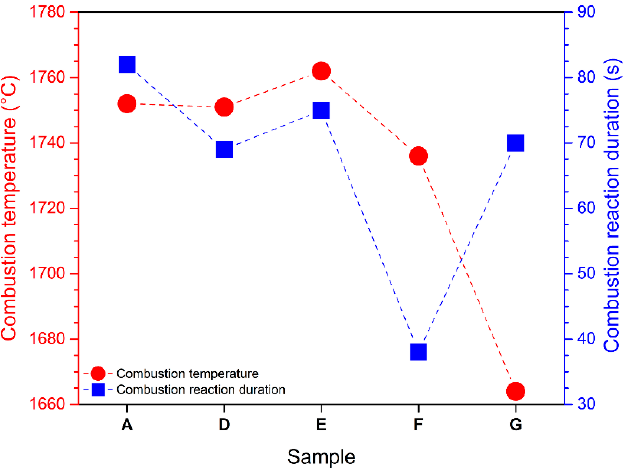
Figure 2. Combustion-reaction temperature and duration. During the combustion process, the sample reached a bright-white incandescence (Figure 3). A large volume of colorless gases evolved during the reaction, leaving behind a white compact solid material.